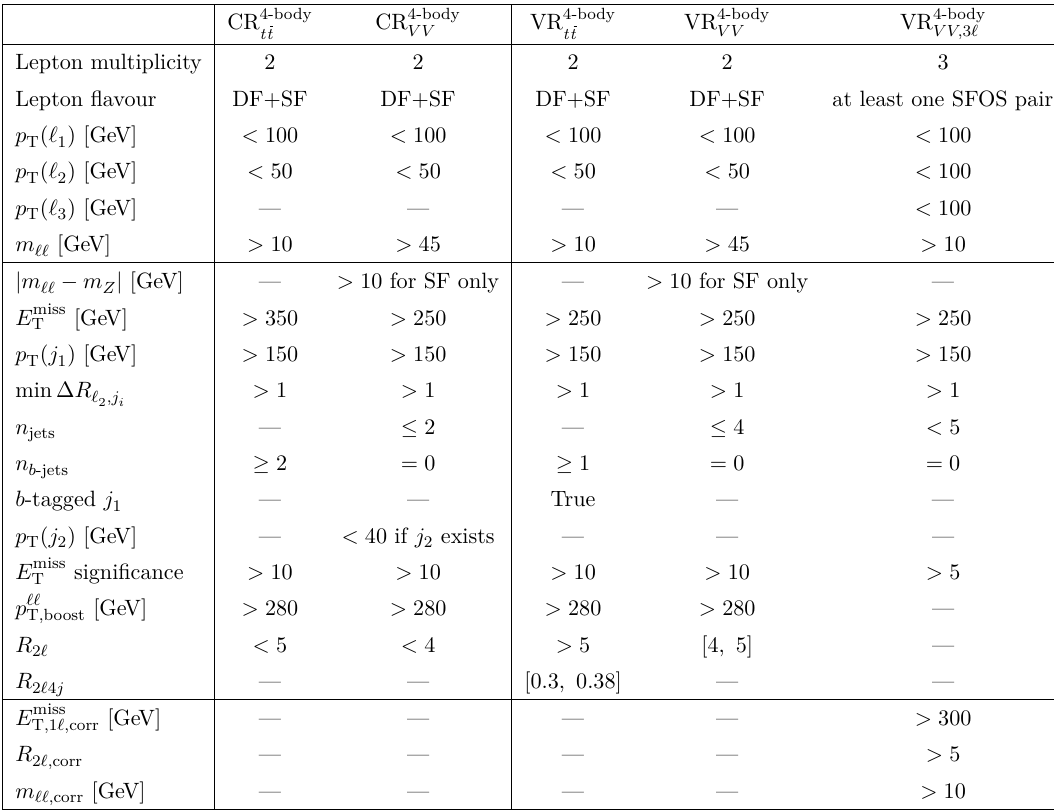
Table 10 . Four-body selection. Control and validation regions definition. The common selection defined in section 5 also applies to all regions.